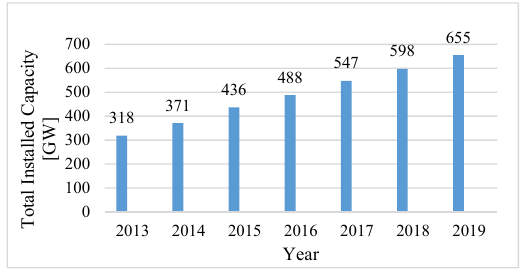
Figure 1. Total globally installed wind power capacity (GW) [2] .